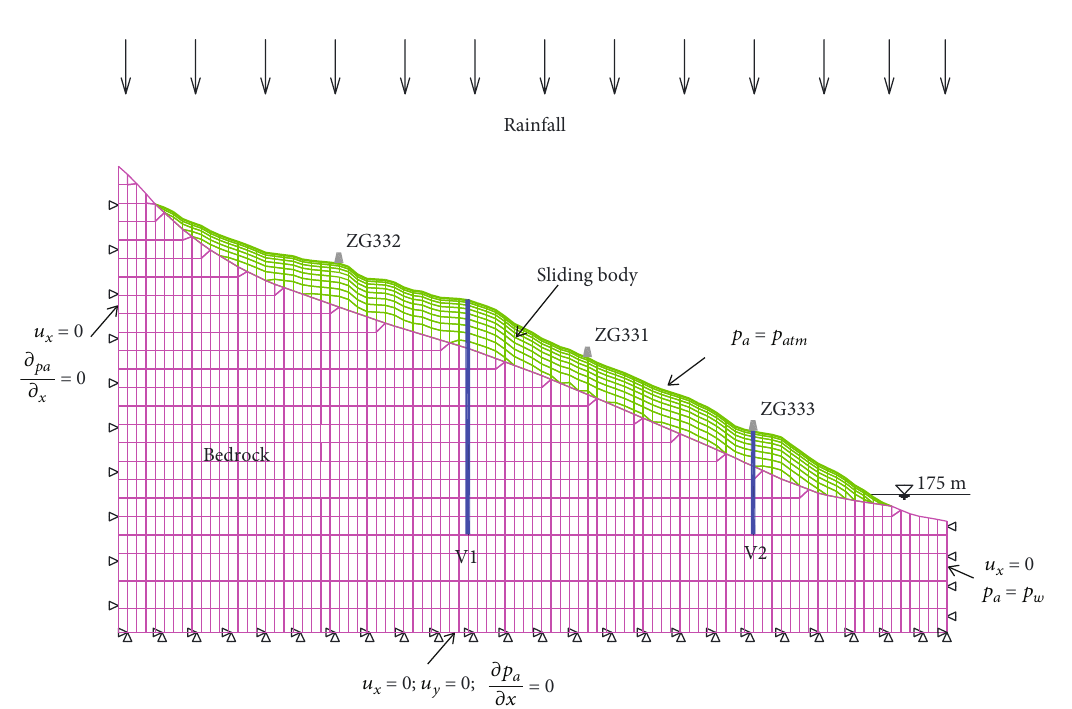
Figure 6: The FEM mesh for the Tanjiawan